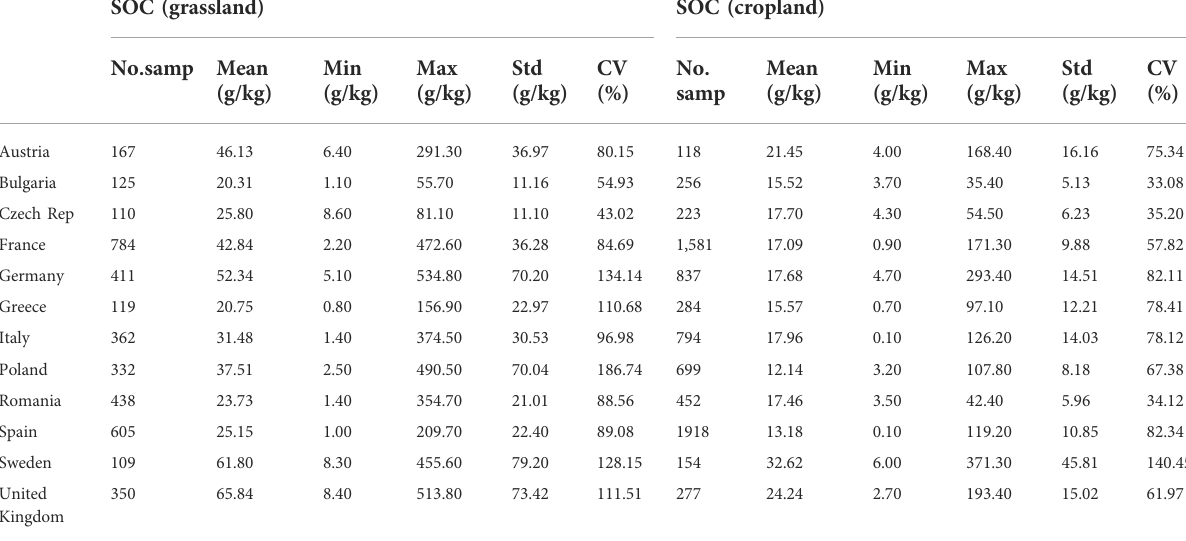
TABLE 1 LUCAS-12 dataset: summary statistics of SOC values per country and LC class. SOC